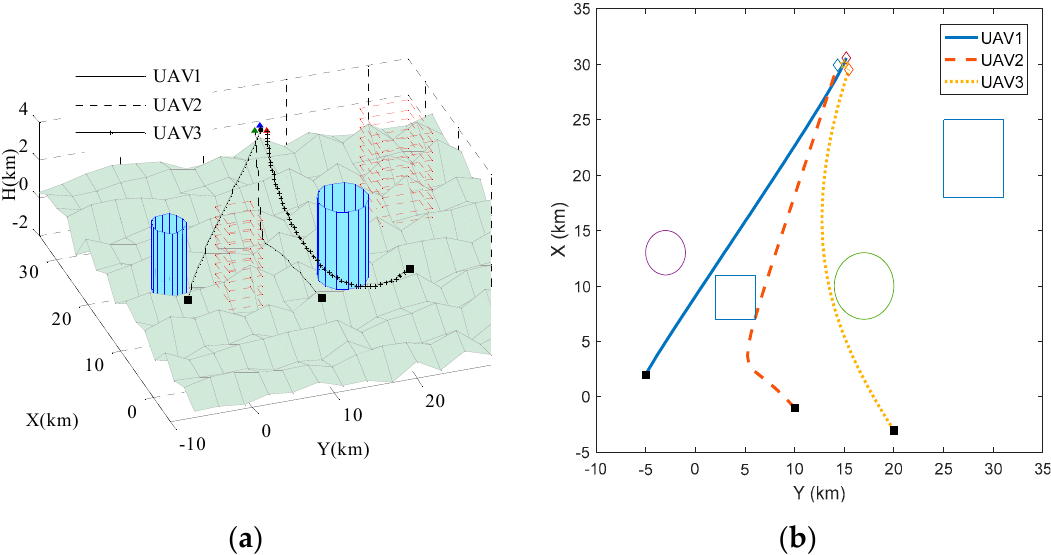
Figure 6. Paths of UAVs for formation rendezvous in 3-D environments. ( a ) 3-D view; ( b ) top view. Figure 7. Curvature and torsion variations with respect to path length. ( a ) Curvature; ( b ) torsion.